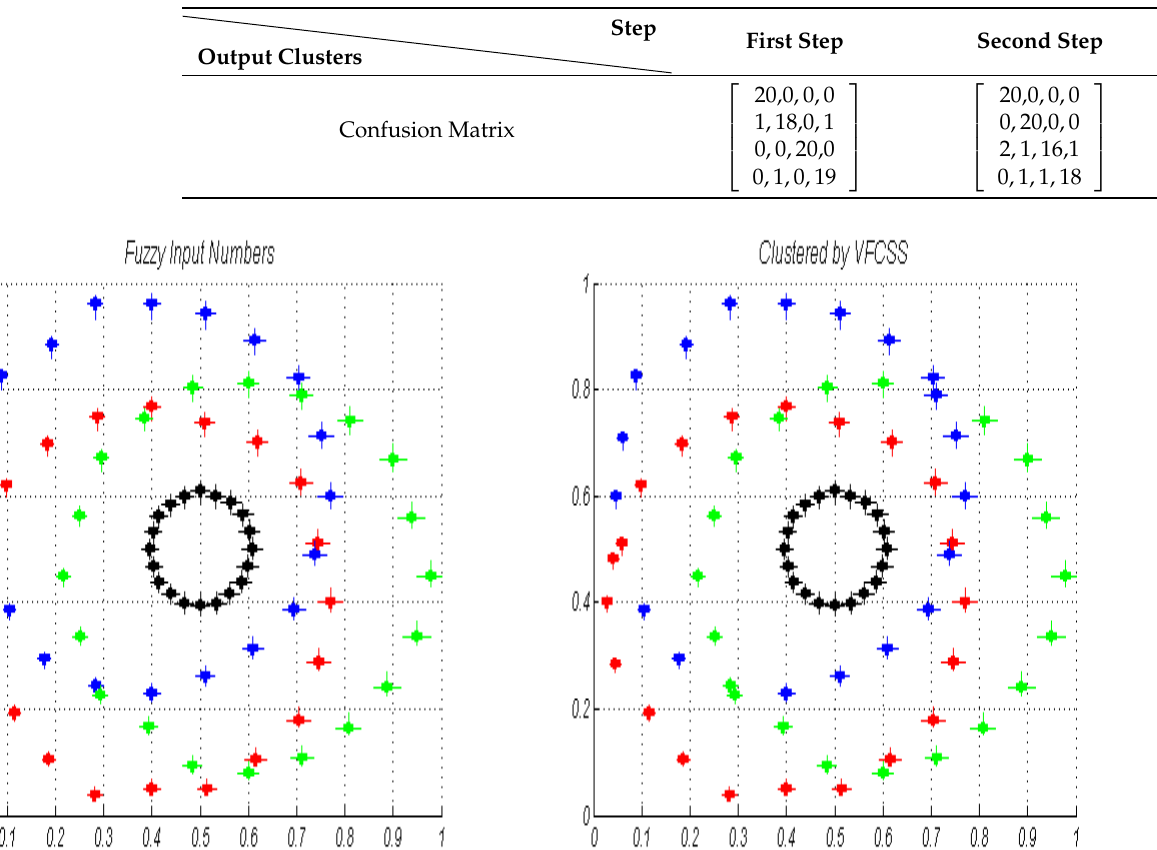
Table 9. CM of VFCSS applied over LR-type fuzzy numbers of Figures 2 and 3 (first and second steps of state 1).